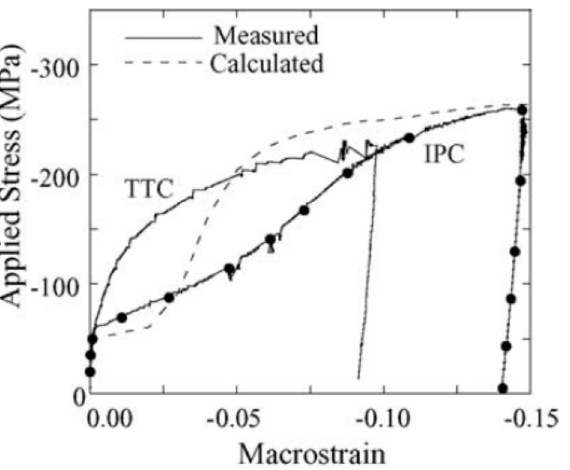
Figure 34. The stress-strain responses of AZ31B Mg alloy during thorough-thickness compression (TTC) and in-plane compression (IPC). The circles on IPC curve represent the strains at which the in-situ neutron diffraction measurements were conducted. The VPSC results are also presented as the dashed line for the IPC loading (After Brown et al. [34]).